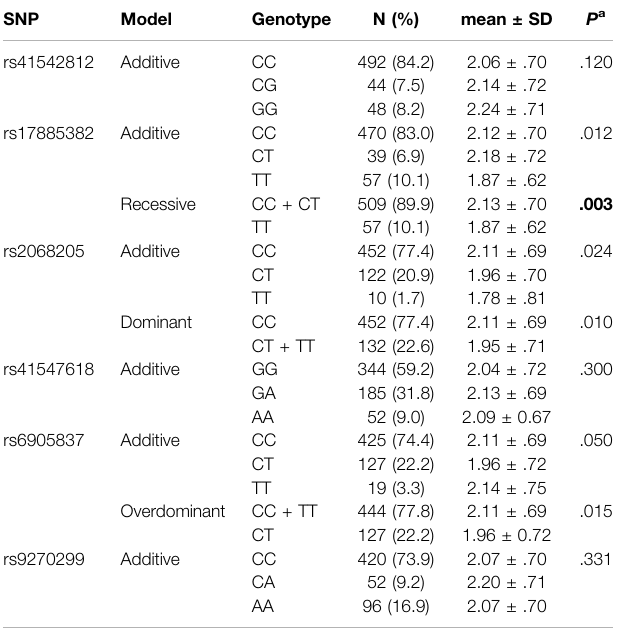
TABLE 4 | Results of covariance analysis for A/H3N2 antibody titers. SNP